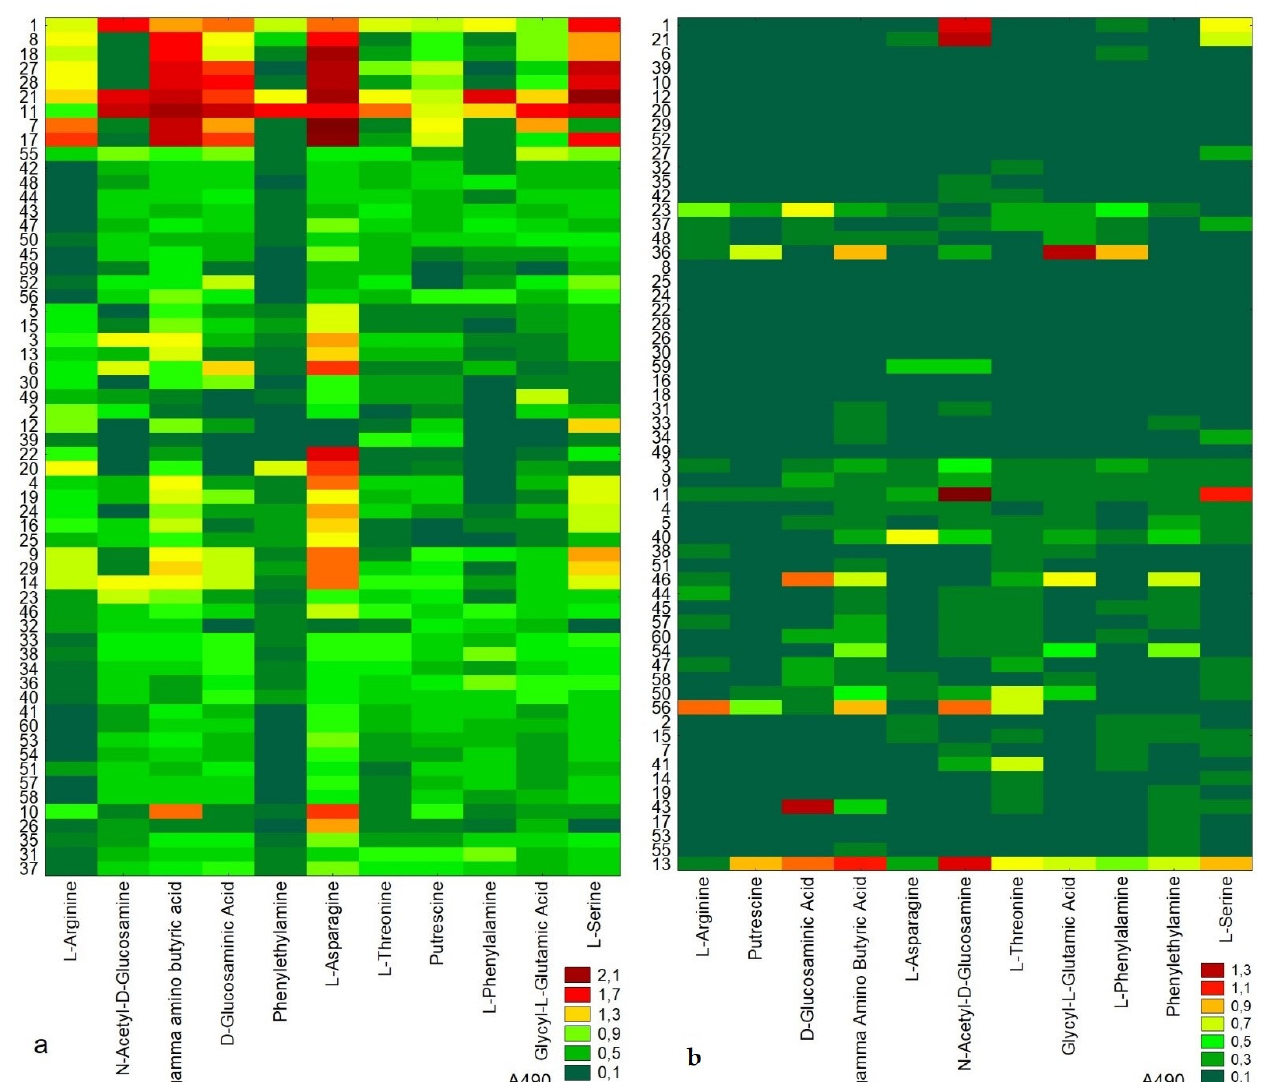
Figure 5. Heat maps showing the substrates utilization by soil microbial communities under aerobic ( a ) and anaerobic ( b ) conditions. Explanations: 1,11,21  lucerne, Mollic Staginic Gleysol (MSG), ( a ) and anaerobic ( b ) conditions. Explanations: 1,11,21 lucerne, Mollic Staginic Gleysol (MSG), Ap, 2, Ap, 2, 12, 22  lucerne MSG, A2, 3, 13, 23  lucerne, MSG, 2ACgg, 4, 14, 24  lucerne, MSG, 3G1, 5, 12, 22 lucerne MSG, A2, 3, 13, 23 lucerne, MSG, 2ACgg, 4, 14, 24 lucerne, MSG, 3G1, 5, 15, 25 lucerne, 15, 25  lucerne, MSG, 3G2, 6, 16, 26  lucerne, Haplic Luvisol (HL), Ap, 7, 17, 27  lucerne, HL, E1, MSG, 3G2, 6, 16, 26 lucerne, Haplic Luvisol (HL), Ap, 7, 17, 27 lucerne, HL, E1, 8, 18, 28 lucerne,